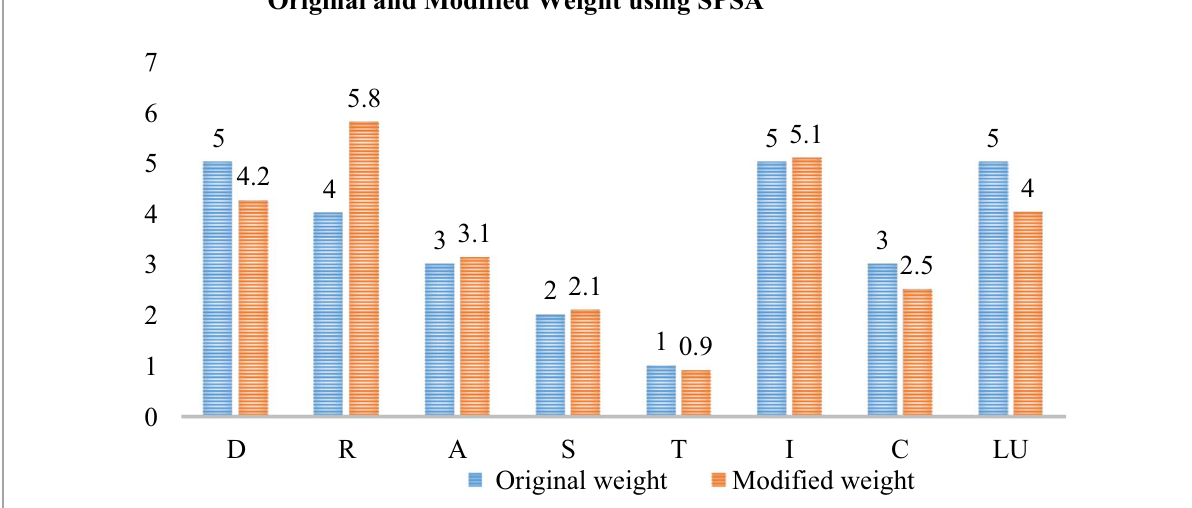
Fig. 9 Weight of Parameters before and after modification